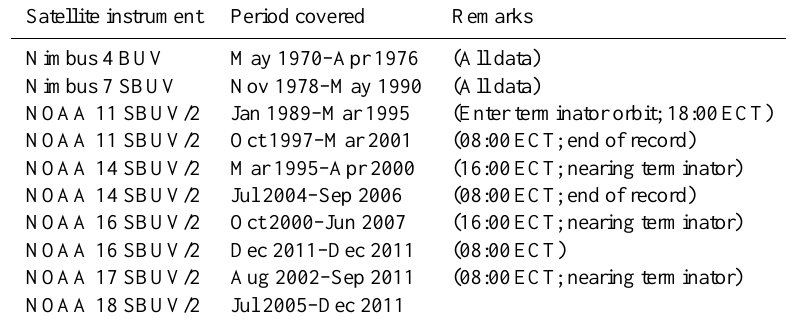
Table 1. Period of coverage by each instrument used in constructing the SBUV merged profile total ozone data record. Satellite instrument Period